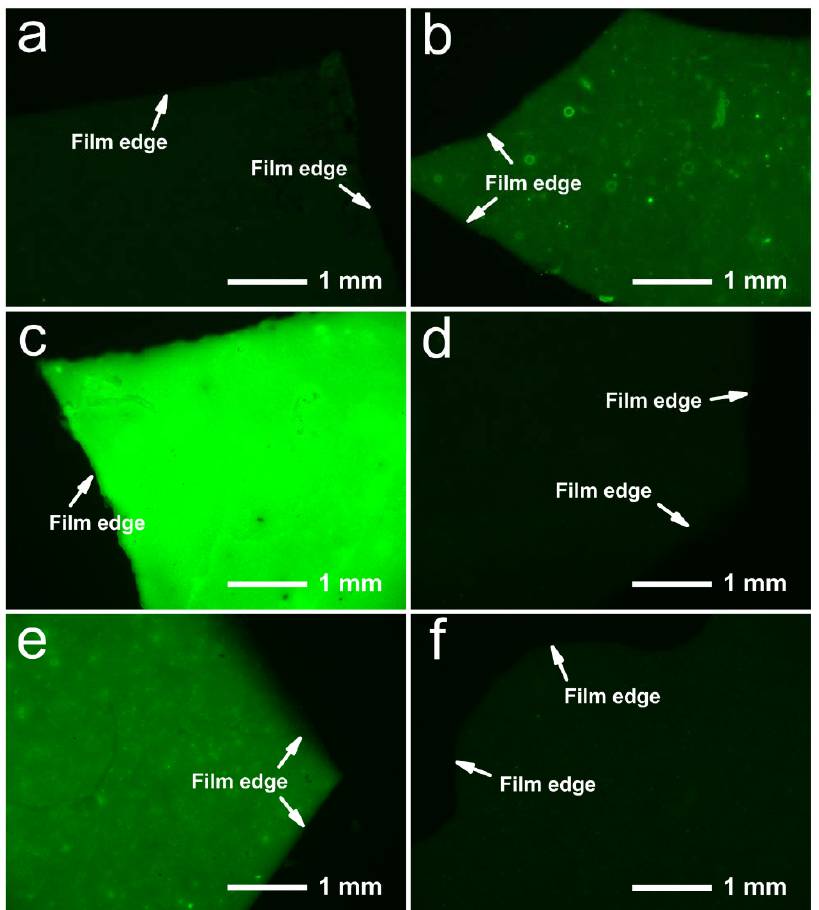
Figure 4. Fluorescence micrographs of drug-loaded nanofibrous membranes: ( a ) CS / PVA nanofibrous membrane, ( b ) CS / PVA / GO nanofibrous membrane, ( c ) CS / PVA / CipHcl nanofibrous membrane, ( d ) CS / PVA / GO / CipHcl nanofibrous membrane, ( e ) CS / PVA / Cip nanofibrous membrane, ( f ) CS / PVA / GO / Cip nanofibrous membrane.